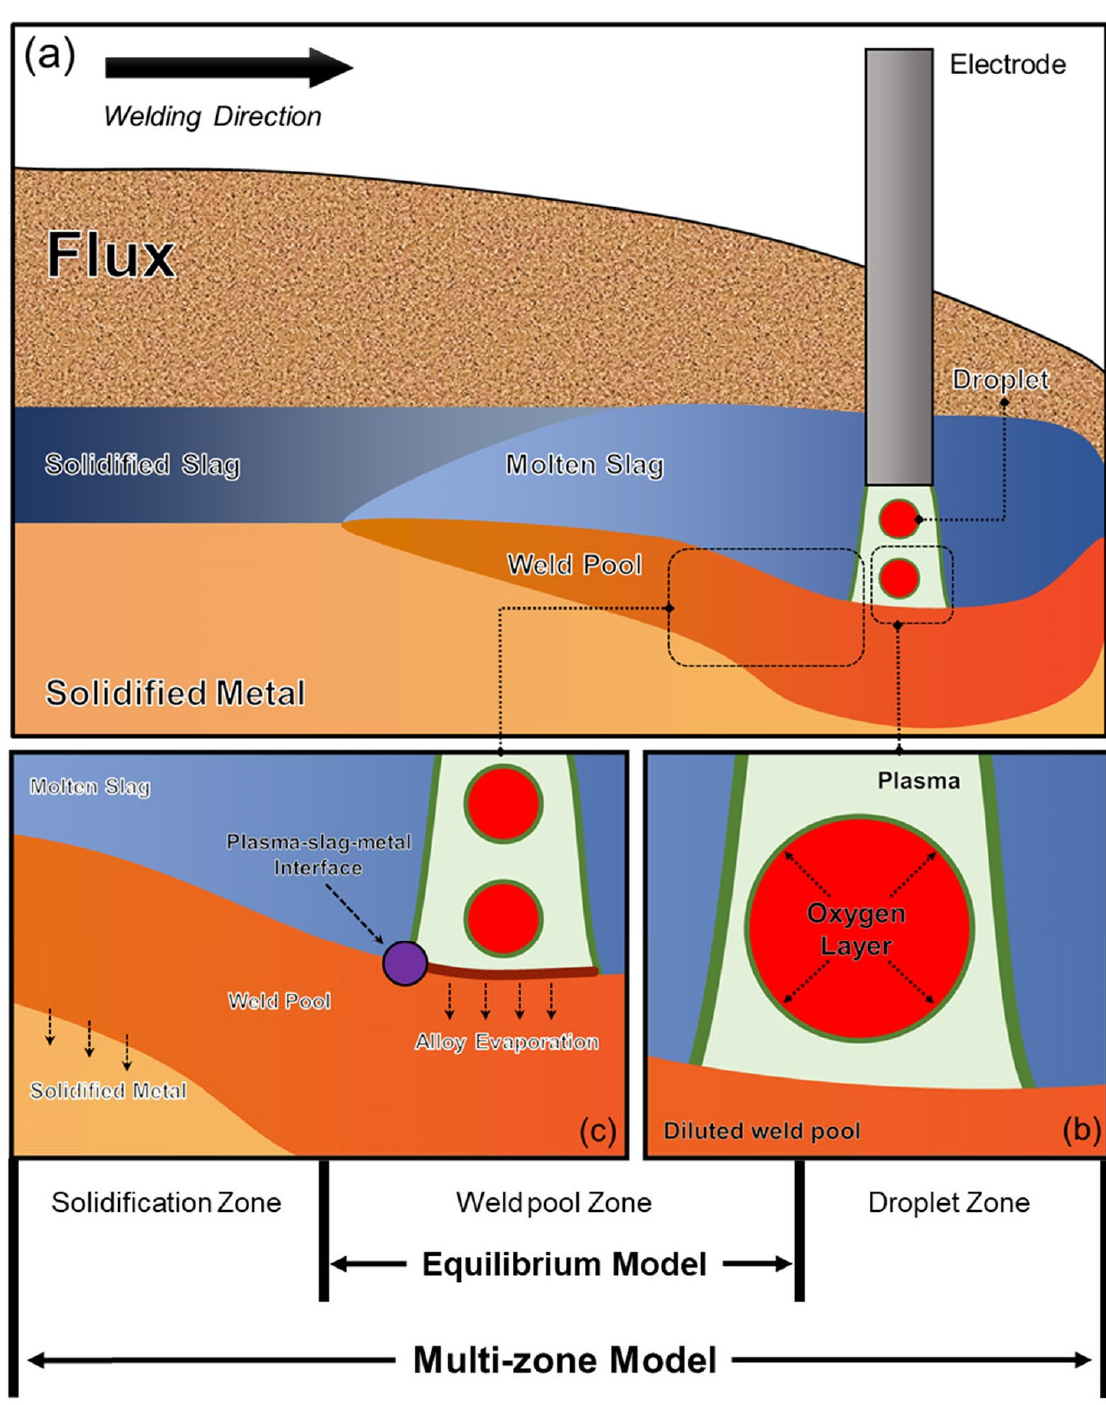
Figure 2. Reaction zones that control the manganese content in WM: ( a ) overall schematic diagram of submerged arc welding, ( b ) chemical reactions in droplet zone, and ( c ) chemical reactions in weld pool and solidification